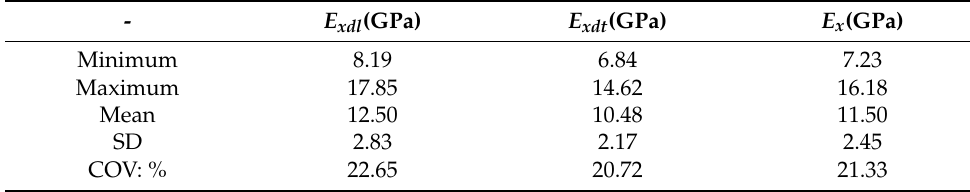
Table 2. Global mechanical properties for the Eucalyptus nitens wood sample.